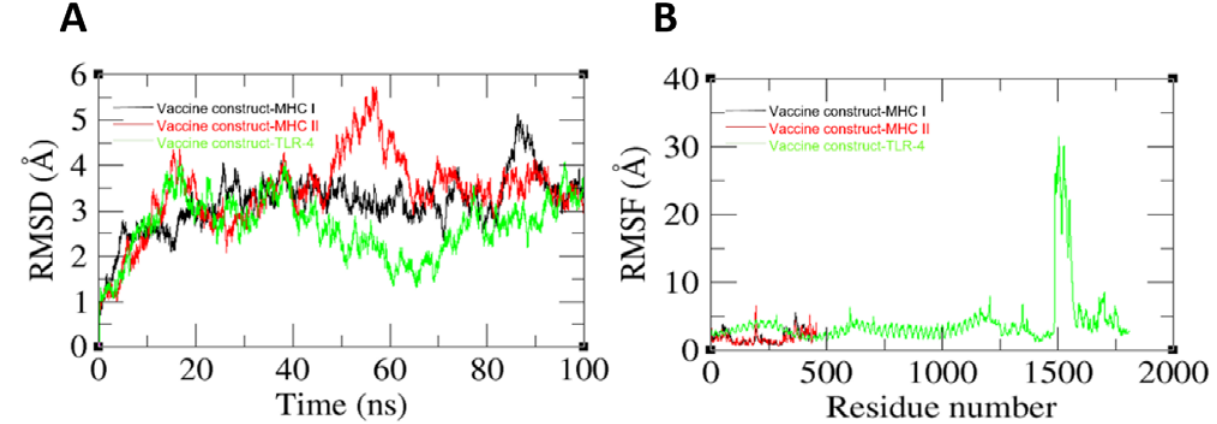
Figure 12. Simulation trajectories analysis to evaluate vaccine stability with the immune receptors. ( A ) RMSD. ( B ) RMSF.